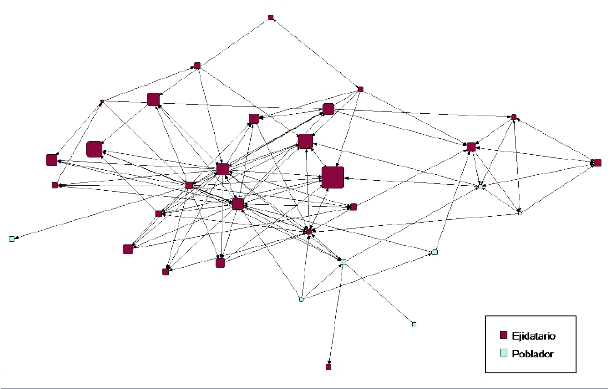
Fig. 1 . Sociogram based on all relationships. Node size is proportional to cash